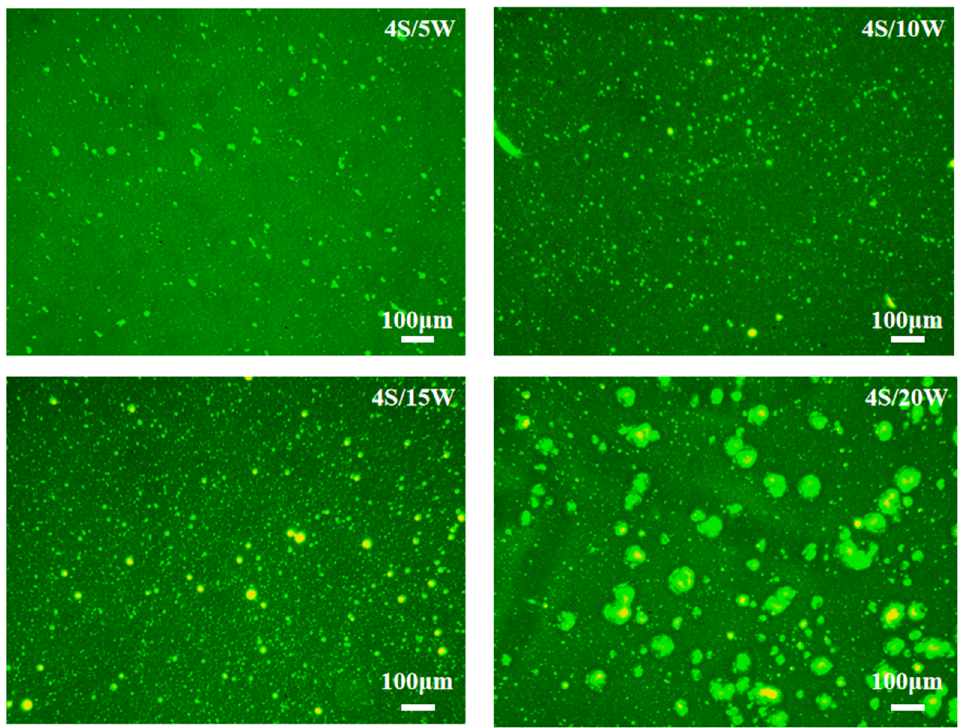
Figure 13. Morphology of WPU/SBS composite modified asphalt.